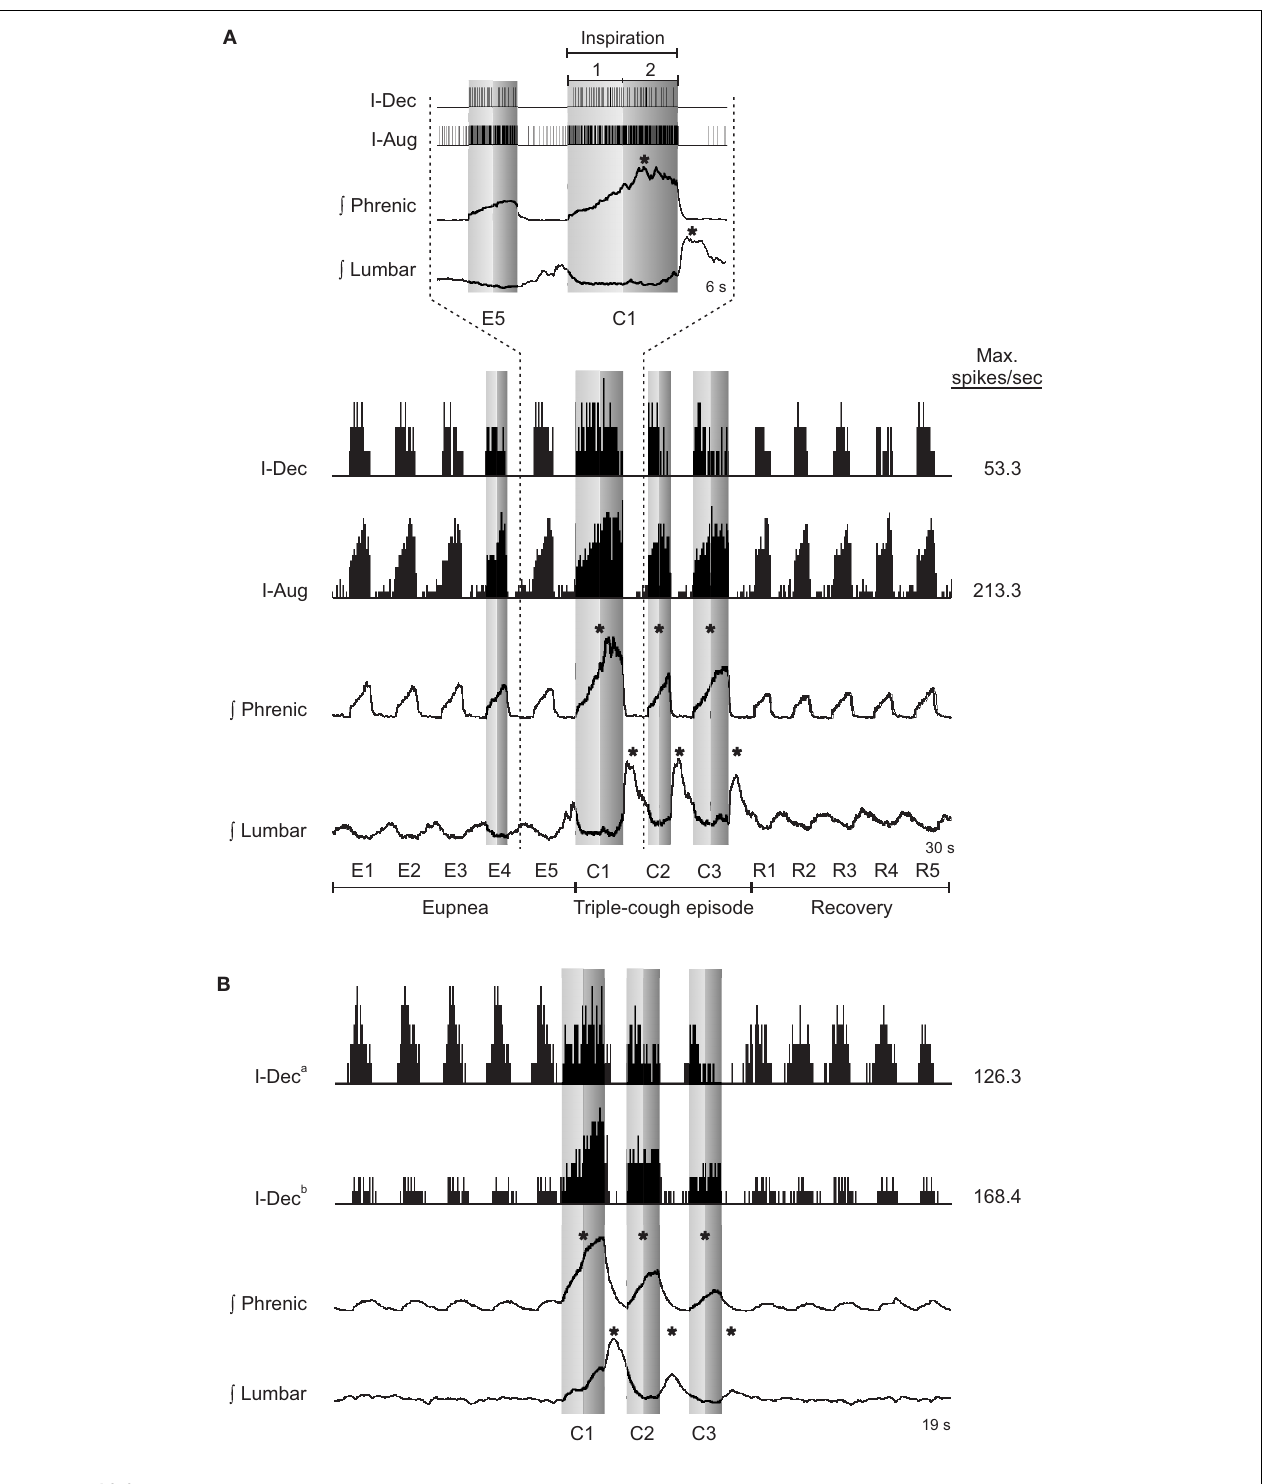
FIGURE 1 | (A) Neuronal spike times (top) and firing rate histograms (firing rate vs. time; binwidth = 75.0ms; bottom) of twoVRC cells recorded during a triple-cough response episode; the discharge identities of these cells did not change during this cough episode. (B) Firing rate histograms (binwidth = 47.5ms) of two I-Dec neurons illustrating their change to an augmenting discharge pattern during C1 of the cough response; cell I-Dec a returned to a decrementing pattern by cycle C2, but cell I-Dec b maintained